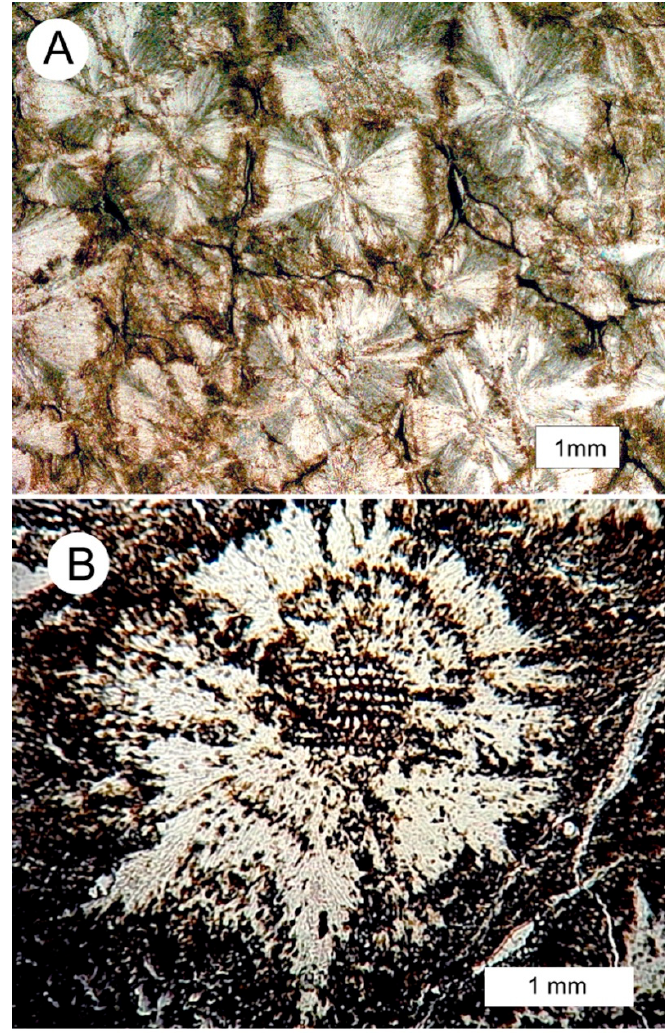
Figure 10. Fossil conifer wood from Port Hardy. ( A ) Thin section shows tissues to have a popcorn-like texture known as fibrous displacive calcite, where the growth of radiating calcite crystals produced severe anatomical distortion. ( B ) Acetate peel illustrates how small shards of cellular tissue commonly served as nuclei for the growth of radiating crystals.